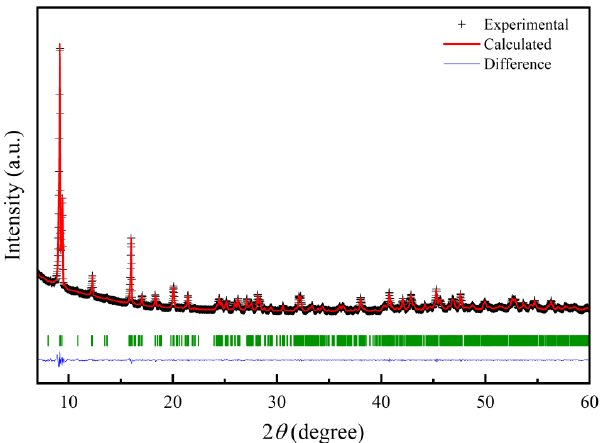
Figure 4. Powder XRD pattern of (Fe 2 Se 3 ) 2 [Fe(dien) 2 ] 0.9 hybrid rods recorded at room temperature (solid crosses) with Rietveld refinements and difference curves.